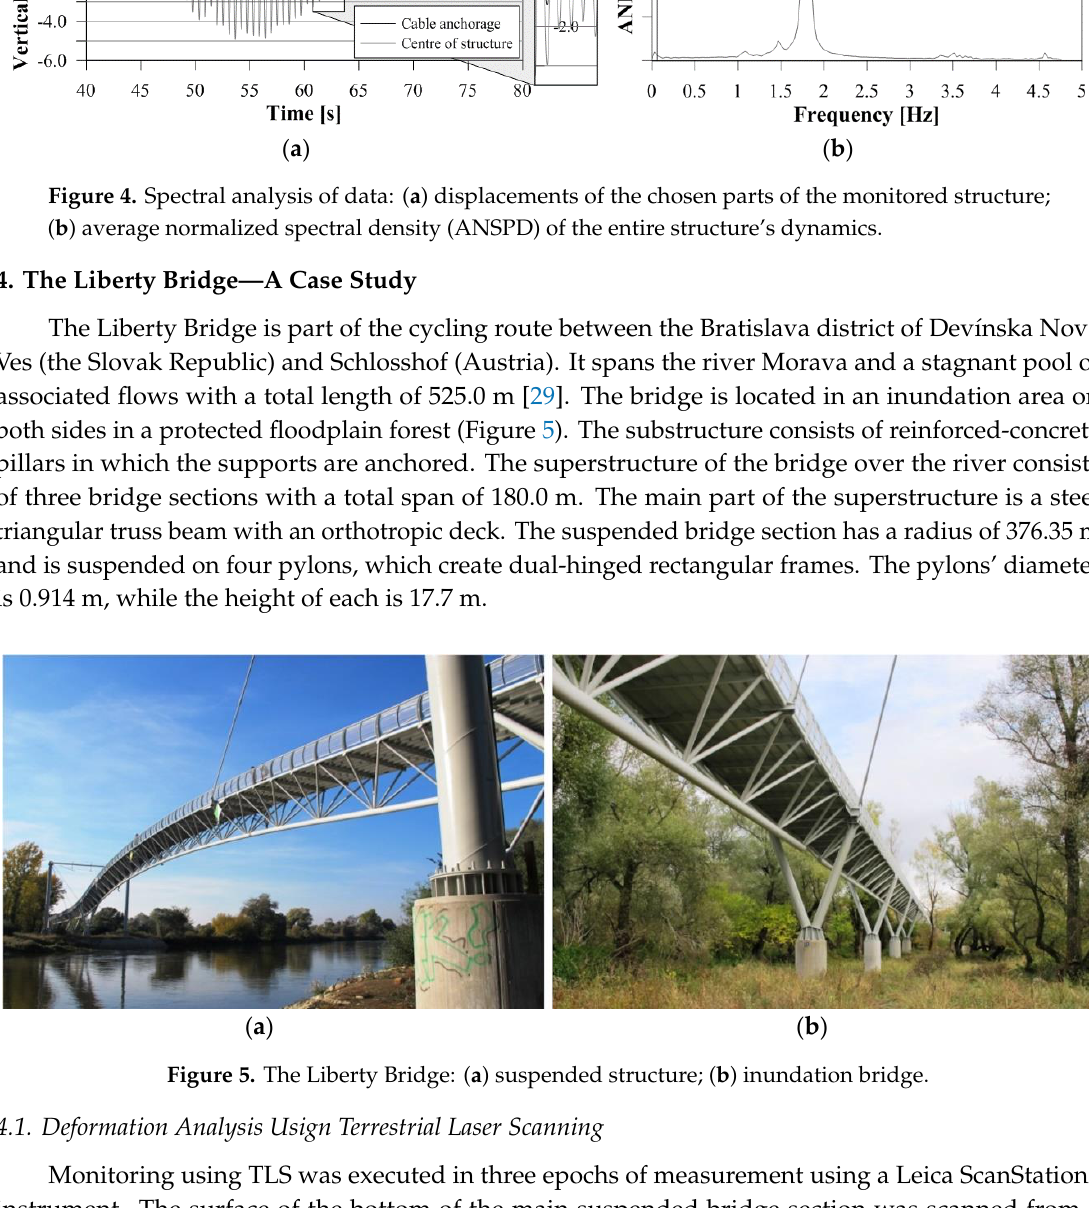
( b ) average normalized spectral density (ANSPD) of the entire structure’s dynamics.